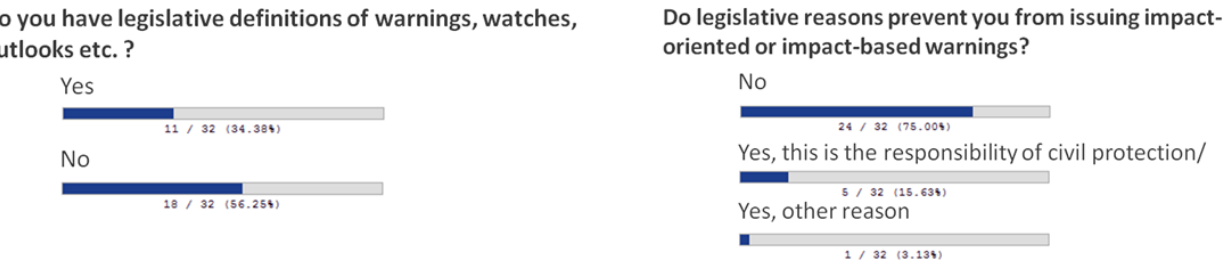
Figure 3. Legal aspects of warnings. 75% of the surveyed NMHSs do not have legislative reasons preventing them from issuing impact- oriented or impact-based warnings. However obstacles are identified in fragmentation of responsibilities of authorities, fears of CPAs to “lose control” in the decision process, federalization and high number of authorities involved, as well as cooperation to CPAs and other authorities, among others.